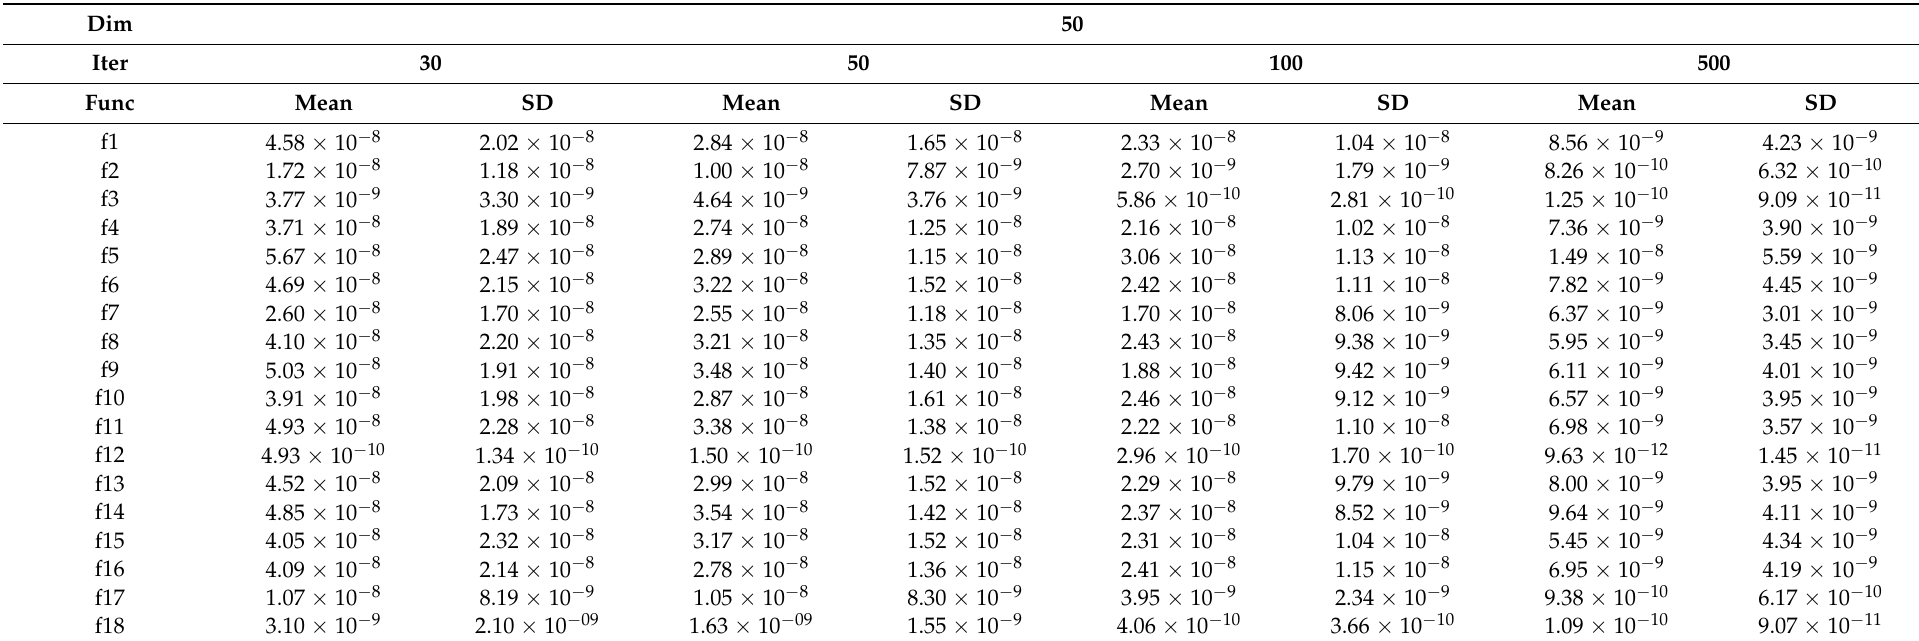
Table 5. MTOA: Results of the experiments for 50